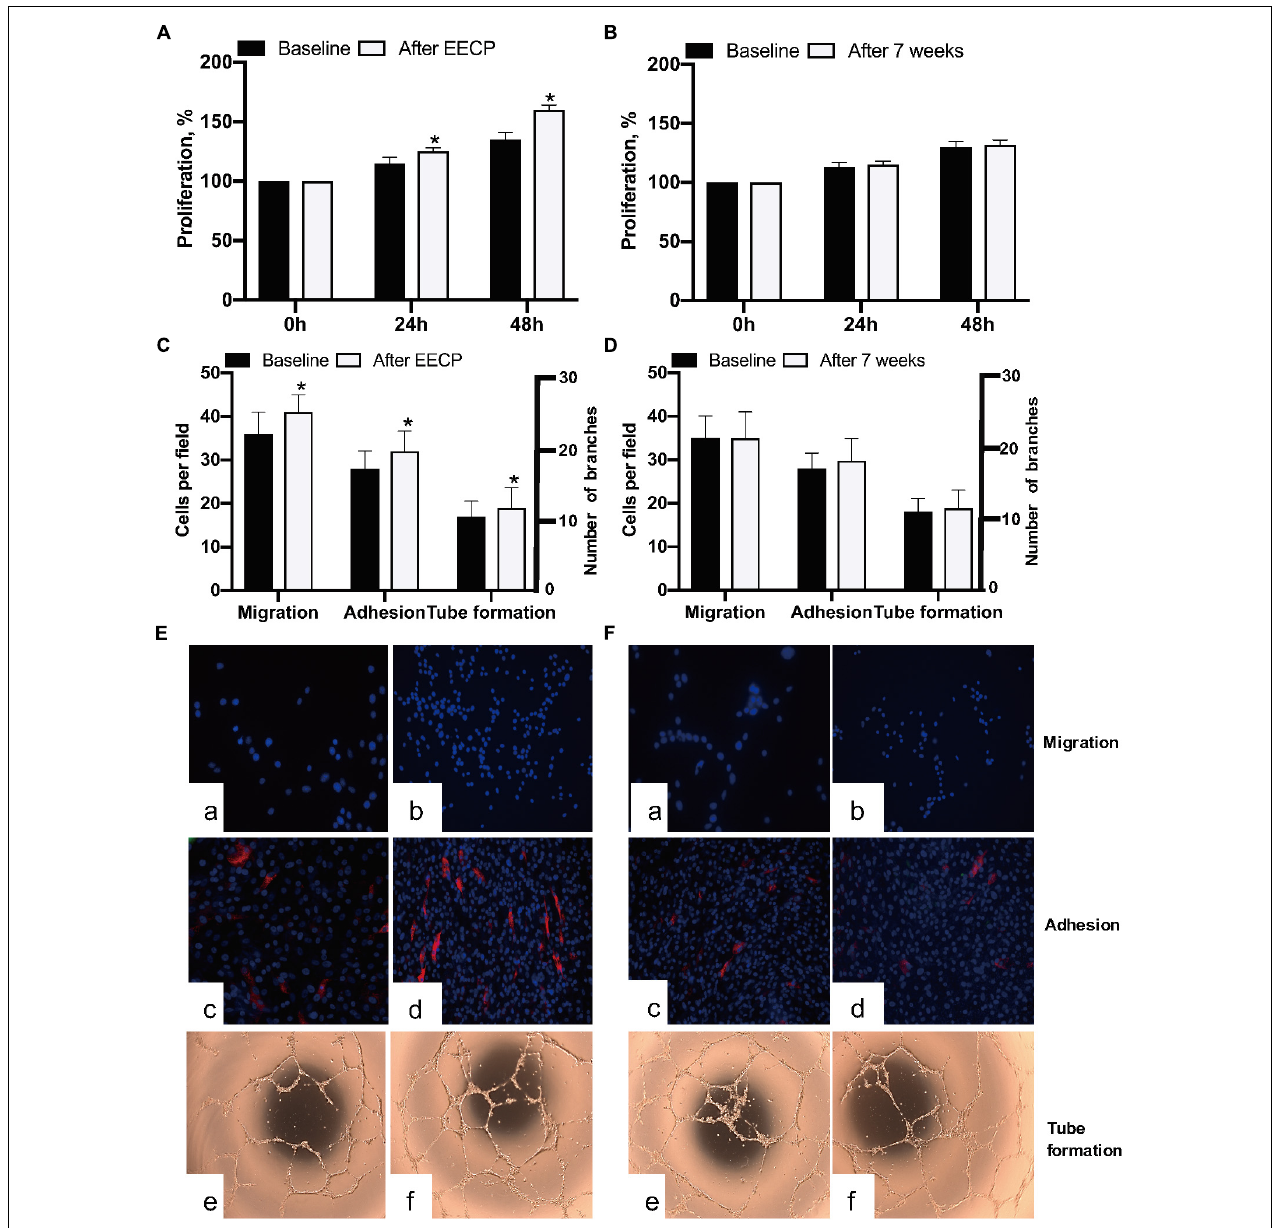
FIGURE 3 | Comparison of EPCs activities in both groups before and after EECP. (A,B) Effect of EECP on EPCs proliferation. (C,D) Quantification analyses elucidated the differences of migration, adhesion, and tube formation capacity in EECP and control group. (E) Representative photographs showing EECP improved migration (a,b) , adhesion (c,d) , and tube formation (e,f) of EPCs in the interventional group. (F) Representative photographs showing no changes of migration (a,b) , adhesion (c,d) , and tube formation (e,f) found in the control group after 7 weeks. * means the difference between groups is statistically significant ( P < 0.05). EECP: enhanced external counterpulsation; EPCs: endothelial progenitor